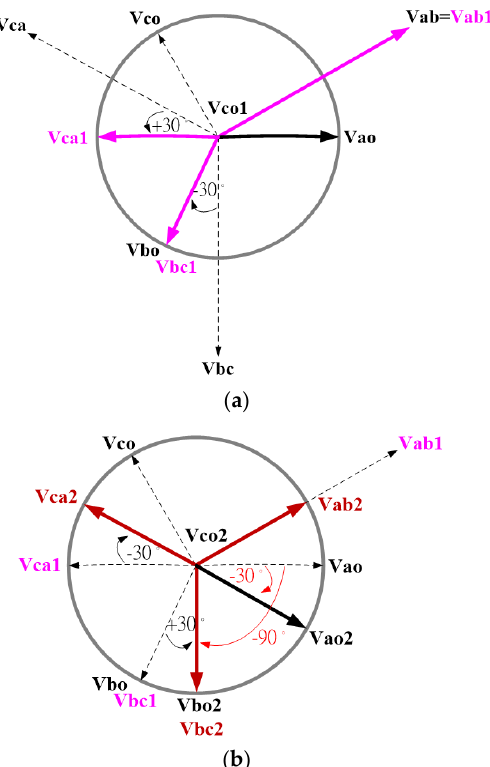
Figure 18. Voltage phasor diagram of the fault-tolerant control when a fault occurs in the switch S c 1 + or S c 2 -; ( a ) unadjusted voltage phase angle; ( b ) adjusted phase angle of the a − phase voltage such that